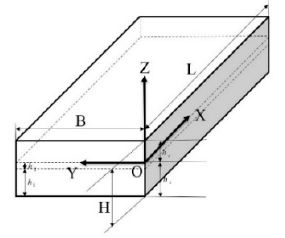
lower metal plates are E c and E s , the Poisson’s ratios are µ c and µ s and the shear moduli are G c and G s ( G = E / [ 2 ( 1 + v )]) . In addition to this, it was assumed that the material properties of the upper and lower layers of the metal plate were isotropic. properties of the upper and lower layers of the metal plate were isotropic.